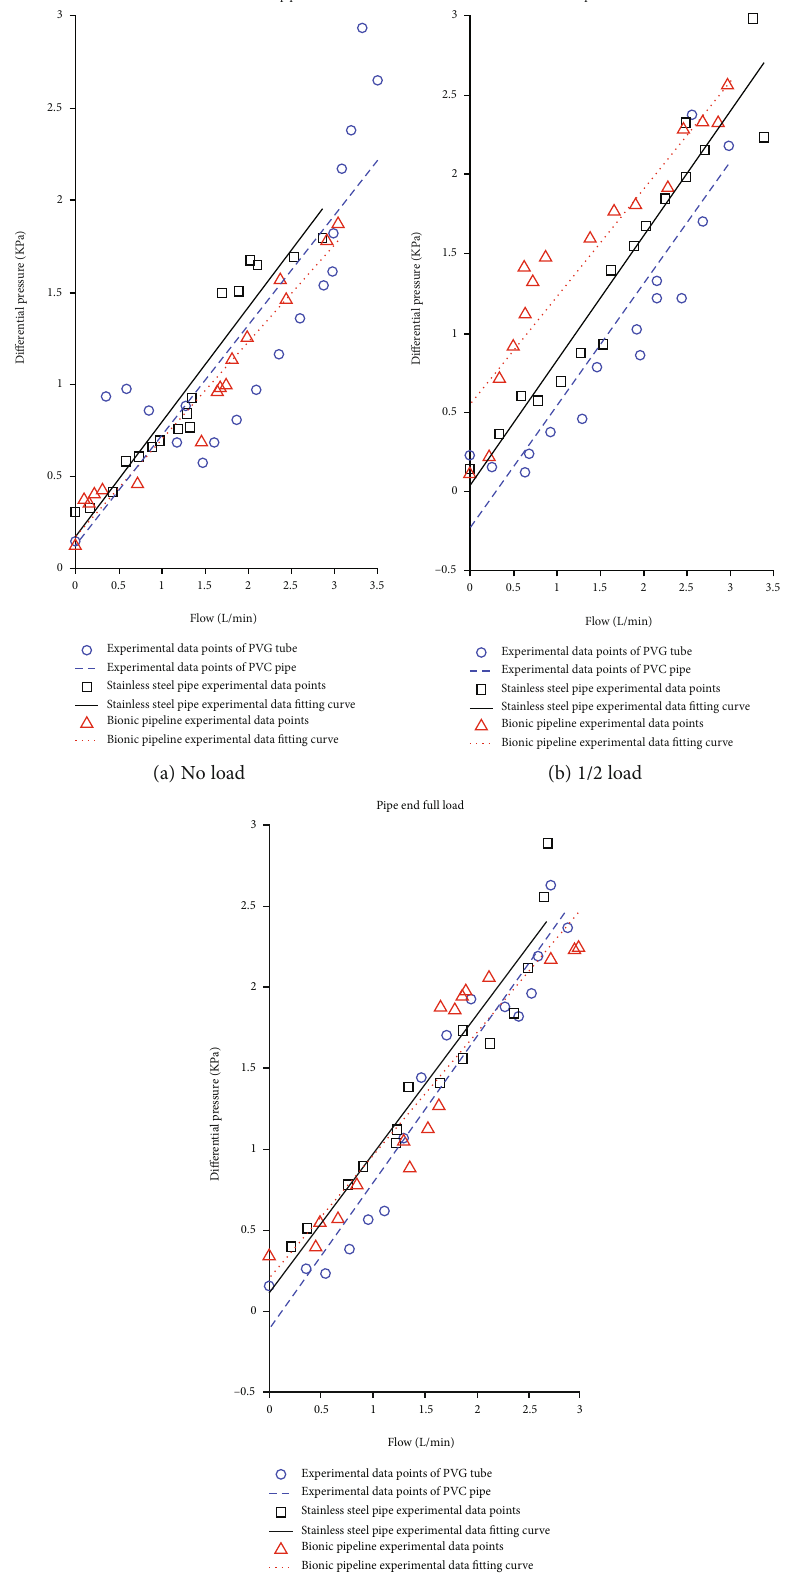
Figure 13: In fl ow liquid-hydraulic